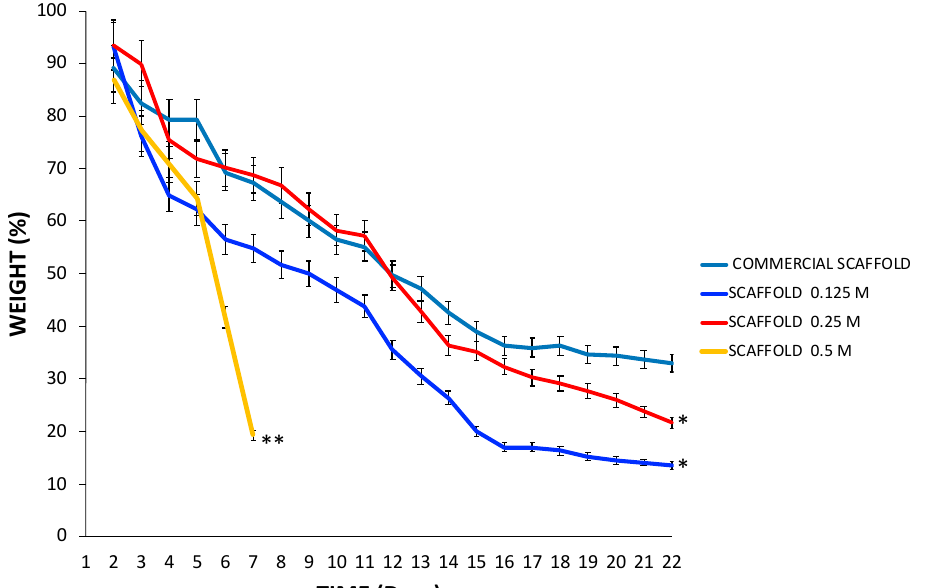
Figure 8. In vitro degradation rate was determined gravimetrically by treating scaffolds in a degra- dation buffer at 37 °C at continuously stirring. The 0.5 M scaffold, processed at the highest HCl concentration, lost more weight than 0.125 M, 0.25 M, and commercial scaffolds at 7 days ** p <0.0001. After this time, the 0.5 M scaffold dissolved in the degradation buffer, and it was impossible to evaluate it. The 0.125 M scaffolds, 0.25 M, lost more weight than commercial scaffolds at 28 days. * p < 0.05. Mean ± SD n > 3.